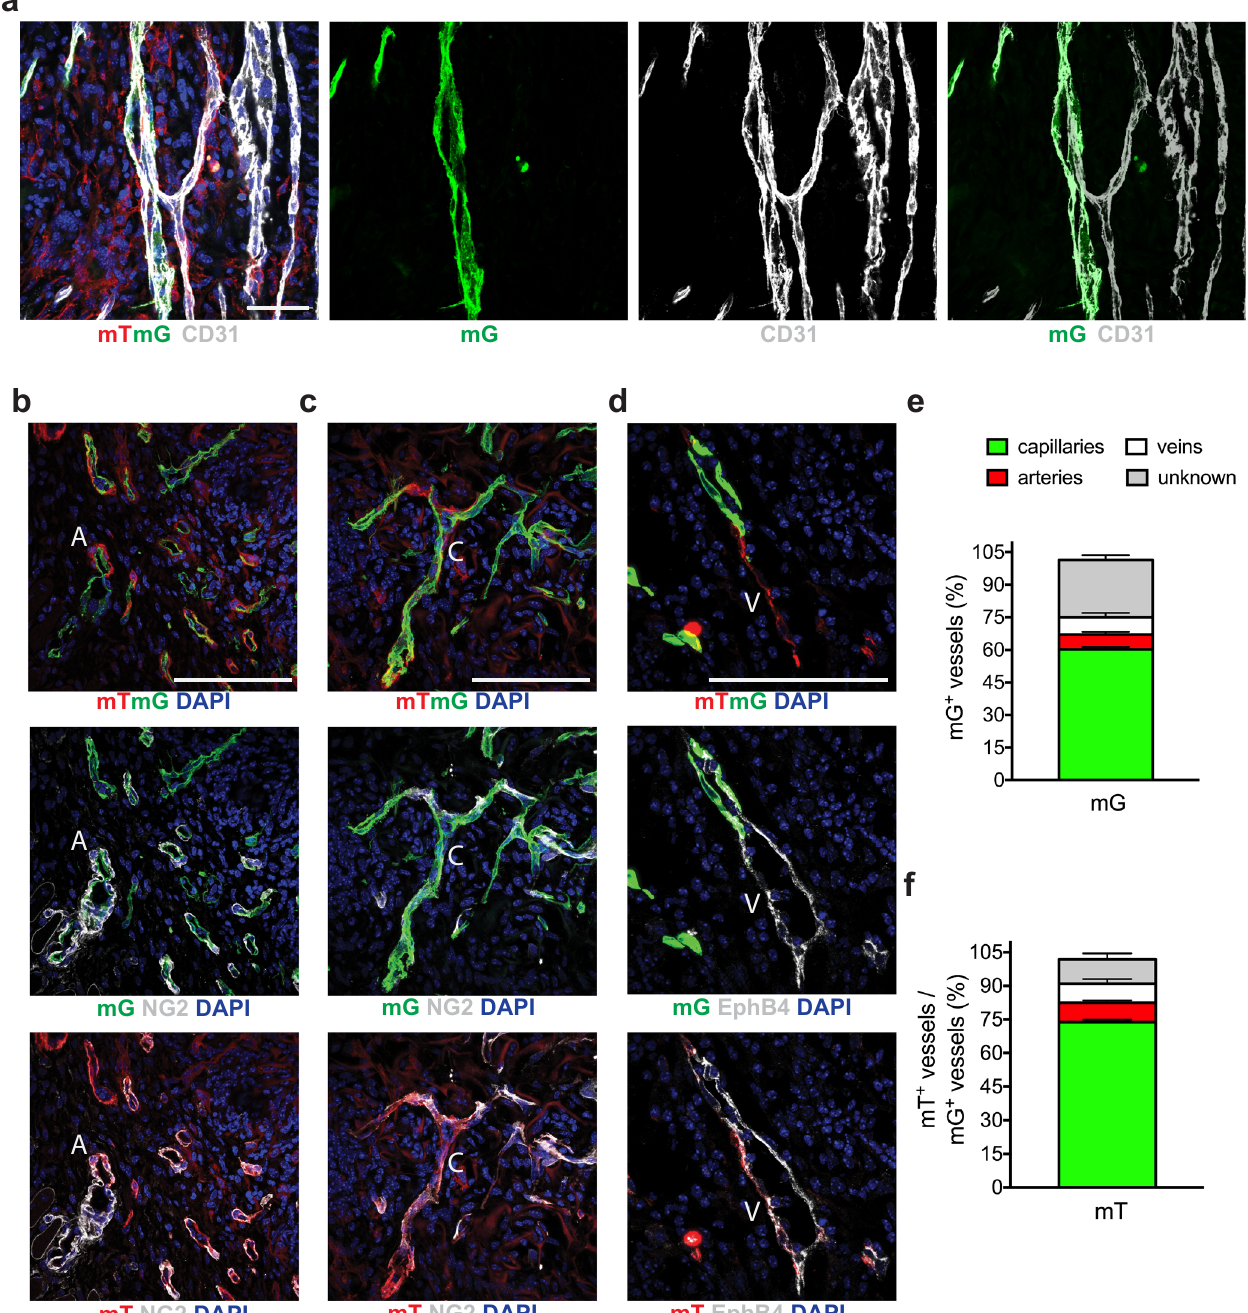
Fig. 3 SVF cells promote the formation of a hierarchical vascular network integrated with host vessels. a Representative image of Cdh5- CreER;mTmG SVF-formed vessels at day 7 after cell implantation. CD31 staining labels both donor (CD31 + EGFP + ) and host (CD31 + EGFP − ) ECs. Separated channels on the right clearly indicate the formation of hybrid vessels, composed of both EGFP + (donor) and EGFP − (host) ECs. b Representative image of Cdh5-CreER;mTmG SVF-formed vessels at day 7 after cell implantation, stained for NG2 to visualize the formation of a large and mature artery (A), wrapped by a thick layer of NG2 + pericytes, which are partially positive for non-endothelial SVF-derived mT. c Representative image of Cdh5-CreER;mTmG SVF-formed vessels at day 7 after cell implantation, stained for NG2 to visualize the formation of a long and thin capillary (C), wrapped by a few sparse NG2 + pericytes. d Representative image of Cdh5-CreER;mTmG SVF-formed vessels at day 7 after cell implantation, stained for EphB4 to visualize the formation of a large vein (V). e Quantitative analysis of the different vessel types formed by SVF-derived mG + EC at day 7 after implantation of SVF isolated from Cdh5-CreER;mTmG mice. f Quantitative analysis of the different vessel types that contain mT + perivascular cells at day 7 after implantation of SVF cells derived from Cdh5-CreER;mTmG mice. Data in ( e , f ) are shown as mean ± SEM. n ≥ 3 per group. Scale bar in ( a – d ) is 100 μ